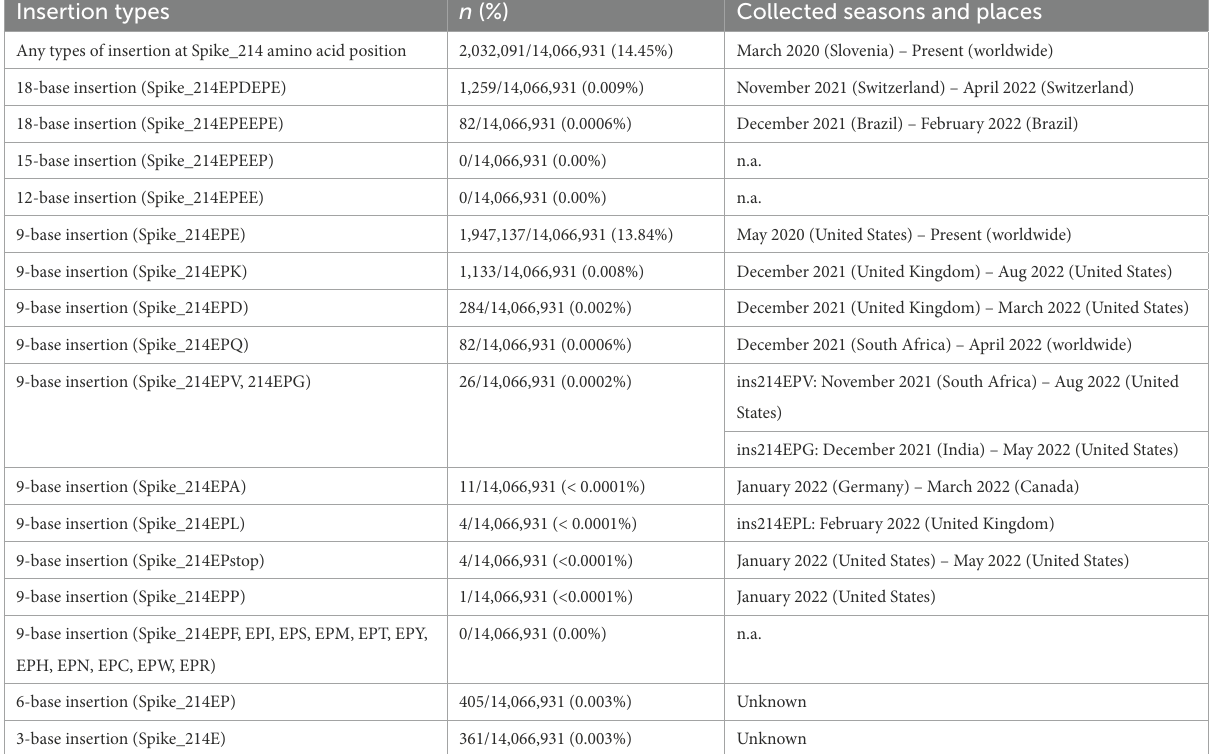
TABLE 2 Numbers of the registered genome sequences with each insertion type at Spike_214 amino acid position in GISAID